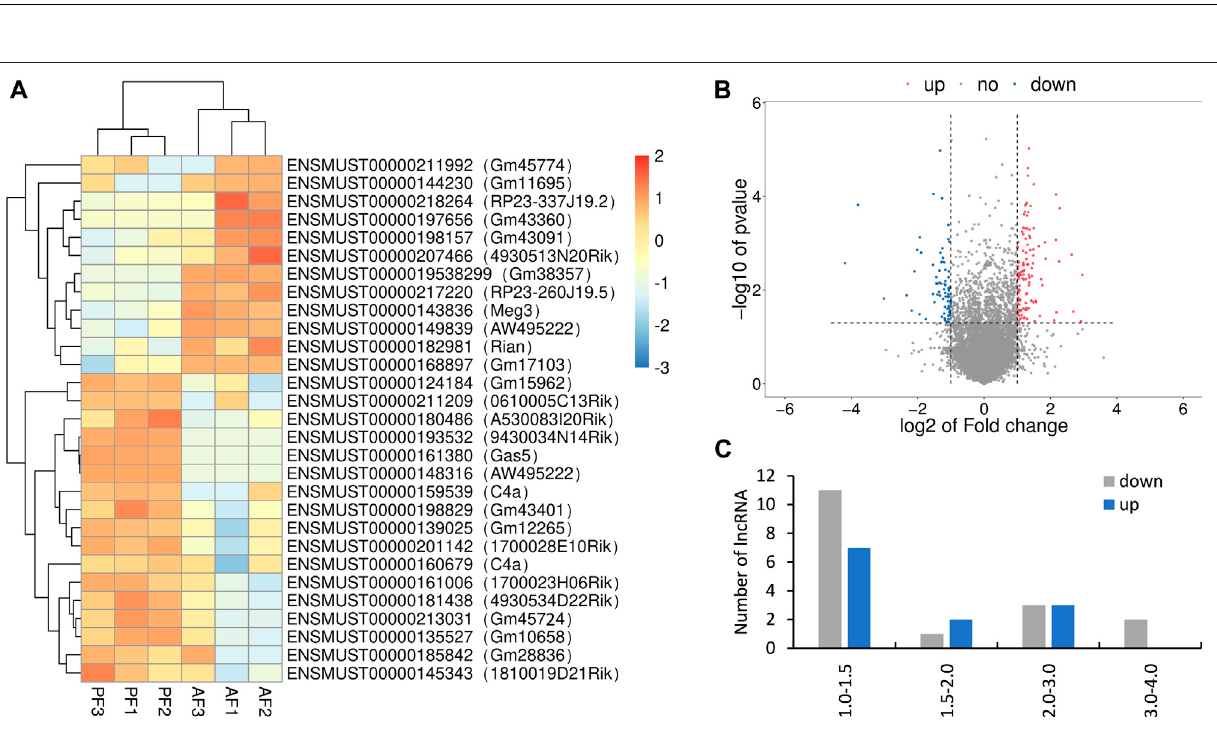
Frontiers in Pharmacology |